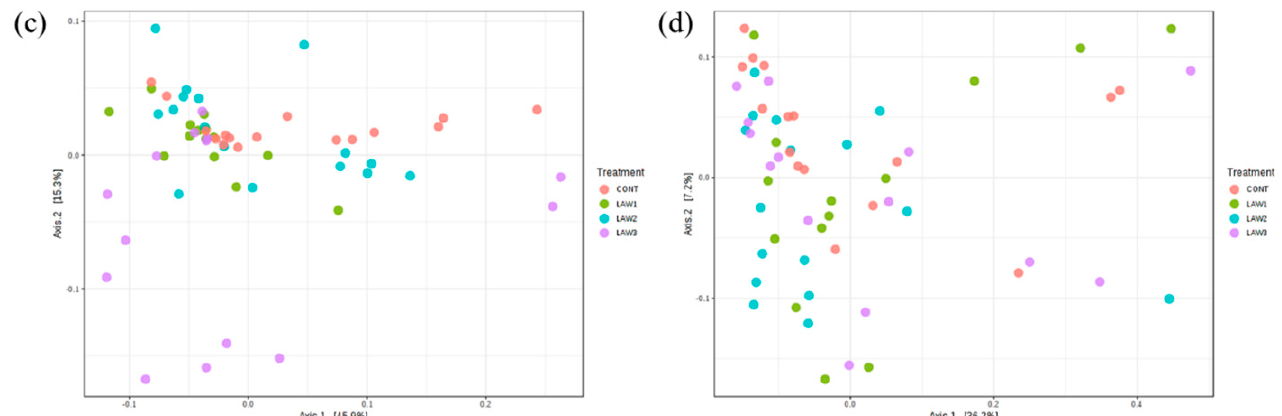
Figure 2. Beta diversity analysis of gut microbiota in piglets orally vaccinated with Lawsonia intracellularis vaccine. Principal coordinates analysis (PCoA) plots of pig gut microbiota at week 0 ( a , b ) (ANOSIM: R = 0.01, p < 0.175) and at week 6 ( c , d ) (ANOSIM: R = 0.11, p < 0.001) based on the weighted ( a , c ) and unweighted ( b , d ) UniFrac distances. Dots represent the gut microbiota from each sample and are color coded according to the treatment group (CONT, LAW1, LAW2, and LAW3) as shown in the legend.